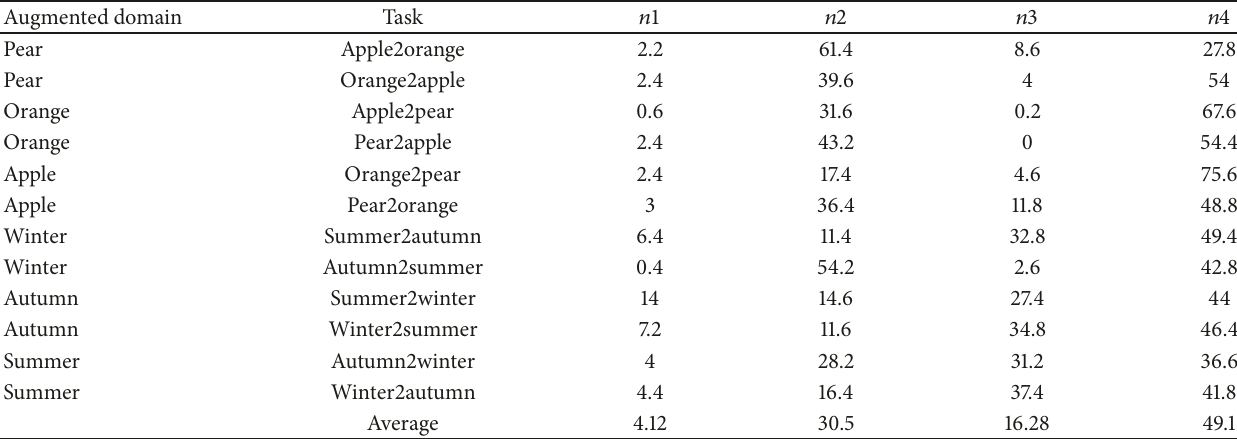
Table 4: This table shows that the results of CycleGAN VS MMGANs, in which the third and the fourth column, respectively, represent a percentage of better quality of generated images by CycleGAN and MMGANs. The last two columns mean the generated images by the two models generated good images and bad images in the testing sets.